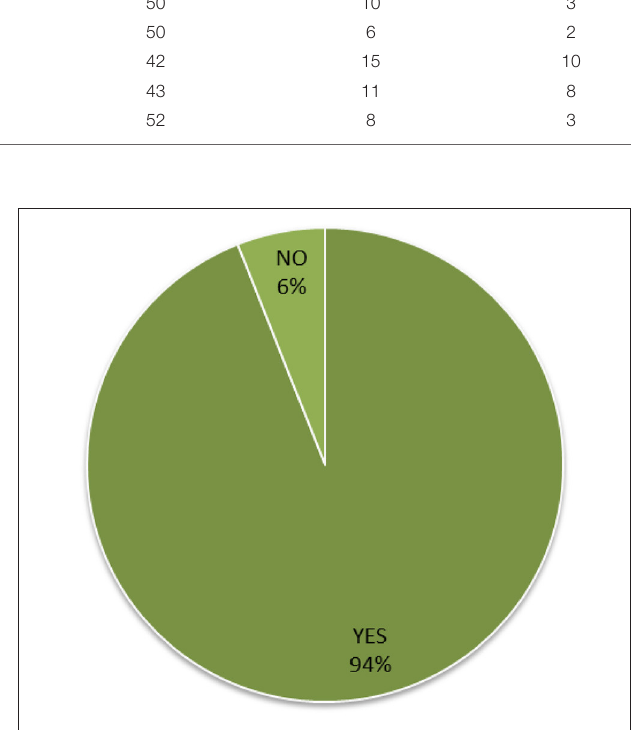
FIGURE 3 | Role of social media to encourage and manage a healthy diet ( n = 308, M = 1.06, SD = 0.243, CI =